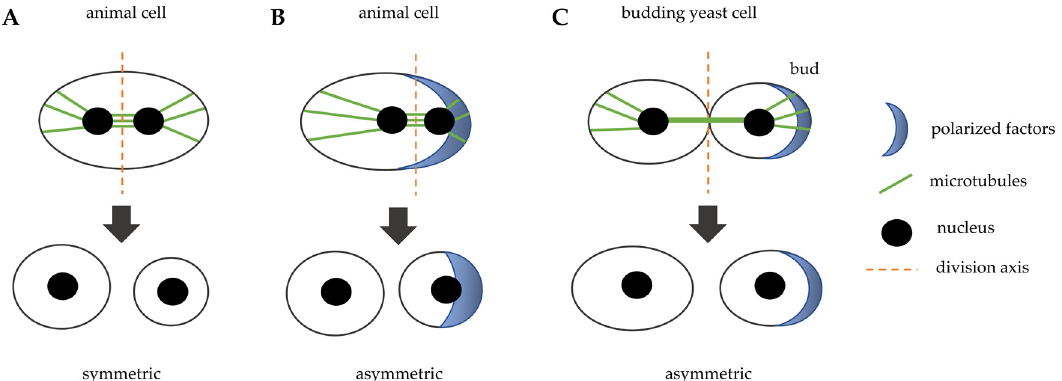
Figure 1. Schematic representation that illustrates symmetric and asymmetric cell division in animal cells and in budding yeast cells. ( A ) the spindle is positioned in the middle of the cell and induces a symmetric division in animal cells. ( B ) cytoplasmatic factors are positioned in a specific site of the cell, they orient the spindle that induces an asymmetric division in animal cells. ( C ) in budding yeast, polarity factors localize at a specific site of the cortex and induce bud emergence, the bud neck is the future division site and the spindle is positioned perpendicularly with respect to the division